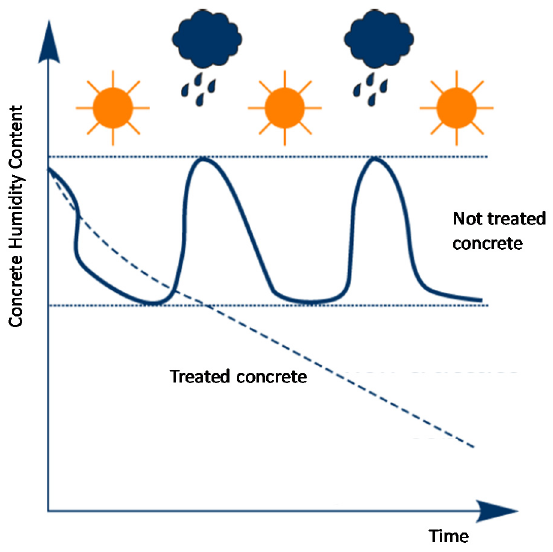
Figure 7. Humidity content trend in concrete over time, with and without hydrophobic treatment (adapted from Bertolini et al. [47]).